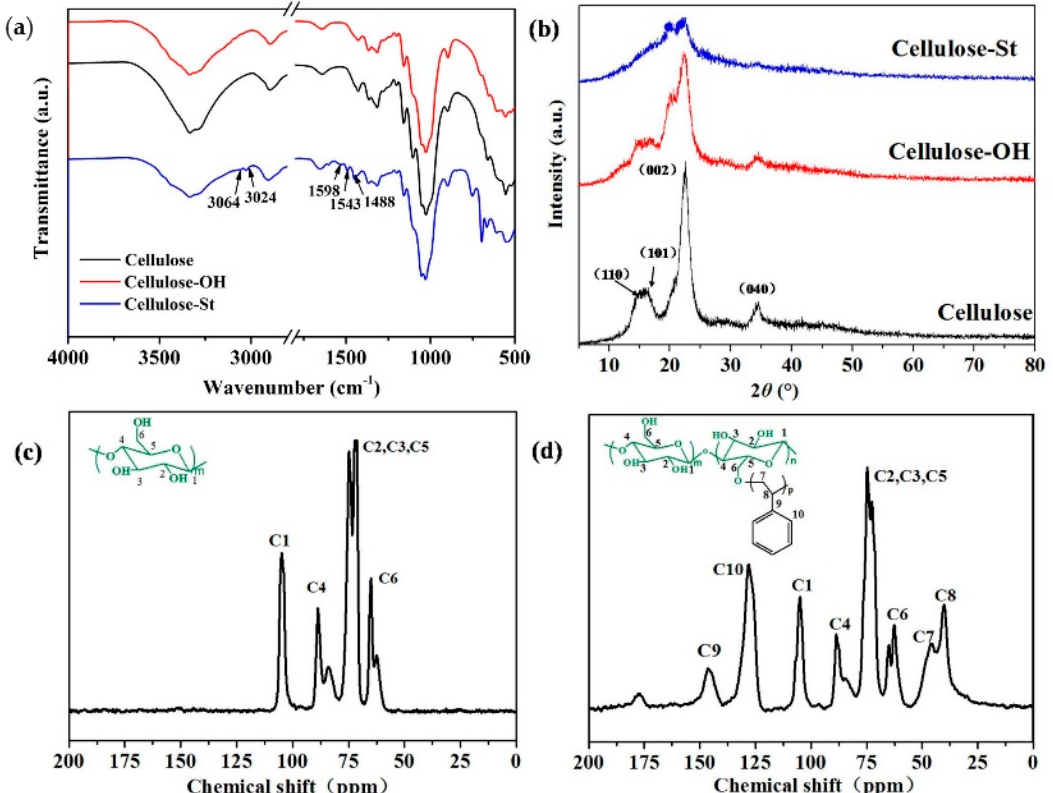
Figure 2. The FTIR spectra ( a ) and XRD spectra ( b ) of cellulose, cellulose-OH, and cellulose-St, and 13 C NMR spectra of cellulose ( c ) and cellulose-St ( d ). ( a )